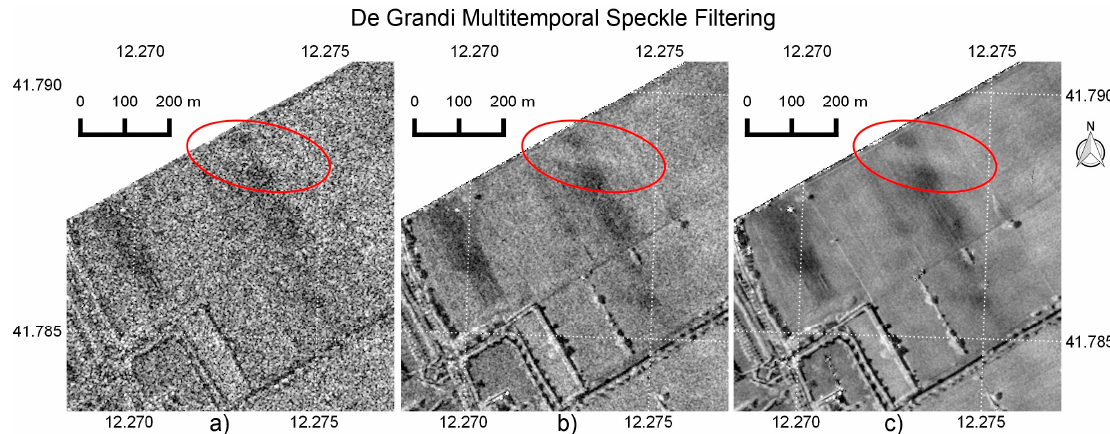
Figure 54. Examples of De Grandi multitemporal speckle filtering. ( a ) σ 0 backscatter image over Northern Canal in Portus AOI, acquired on 20 December 2012. Location of Northern Canal shown in red ellipse; ( b ) Same image as in ( a ) but De Grandi speckle filtered with 9 additional images. The Northern Canal is now easier to distinguish; ( c ) Same image as in ( a ) but De Grandi filtered with all 75 images in Stripmap time series. The Northern Canal appears a lot clearer. COSMO SkyMed images provided by the Italian Space Agency.